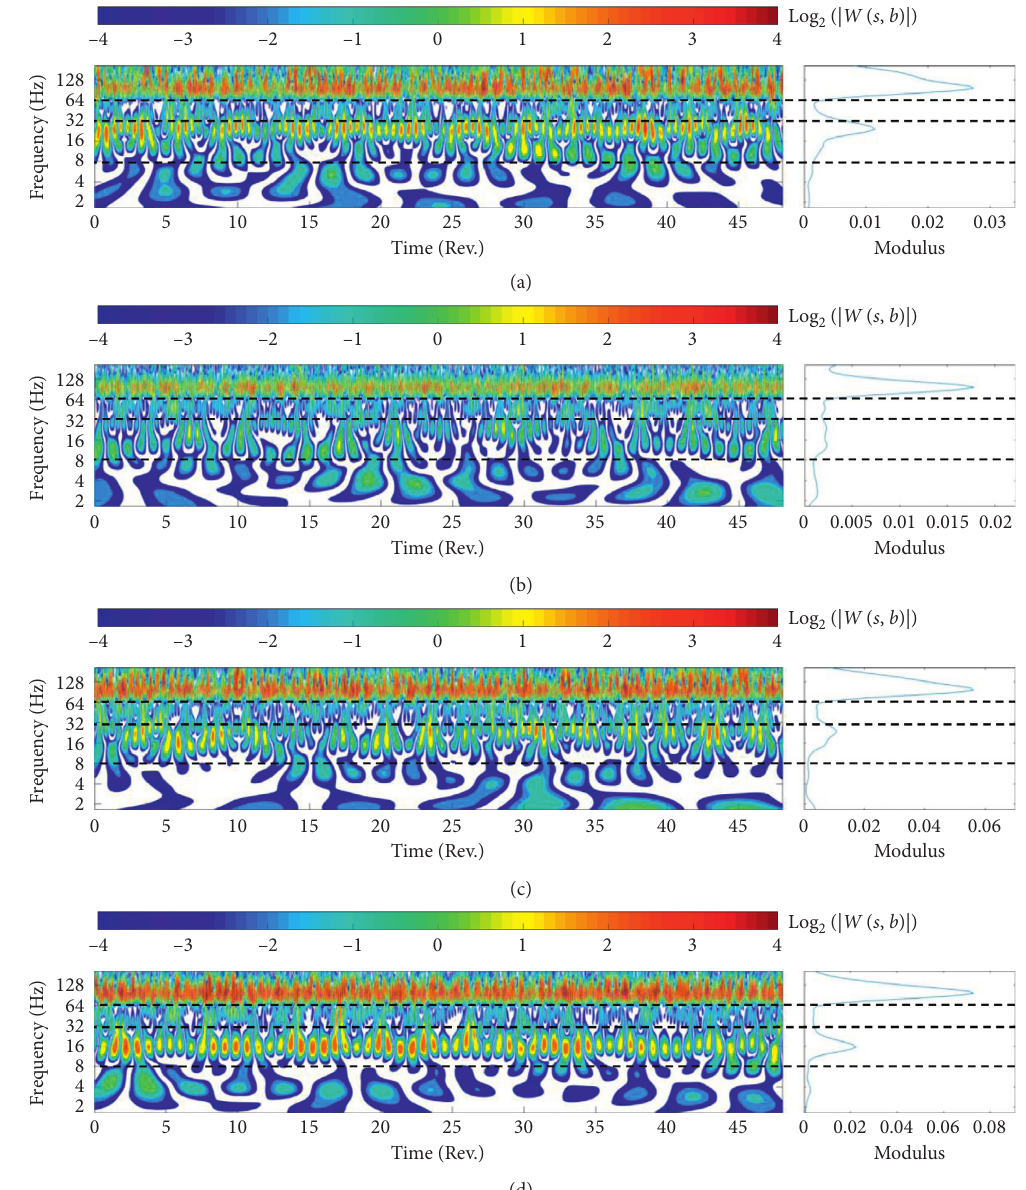
Figure 9: Wavelet modulus spectrum of pressure pulsation at impeller outlet with different tip clearances. (a) t � 0.2mm. (b) t � 0.5mm. (c) t � 0.8 mm. (d) t � 1.1